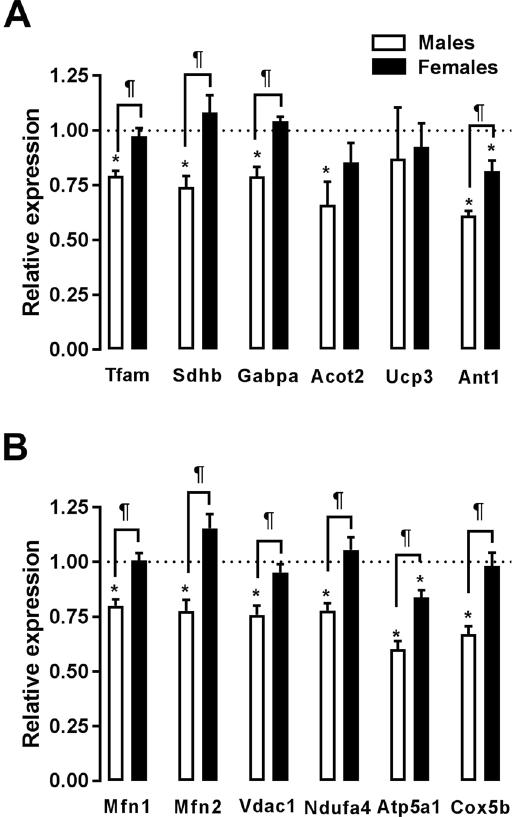
Figure 6. Evaluation by real-time quantitative RT-PCR of the LV mRNA levels of genes encoding for markers of mitochondrial biogenesis and function ( A and B ). The results are reported in arbitrary units (AU) as the mean ± SEM (n = 5–6/gr.). The mRNA levels of the sham (sham-operated animals) groups (ShM and ShF) were normalized to 1 and are represented by the dotted line. White columns represent the ArM group, and black columns represent the ArF group. * p < 0.05 vs. the corresponding sham group and ¶ p < 0.05 between the ArM and ArF